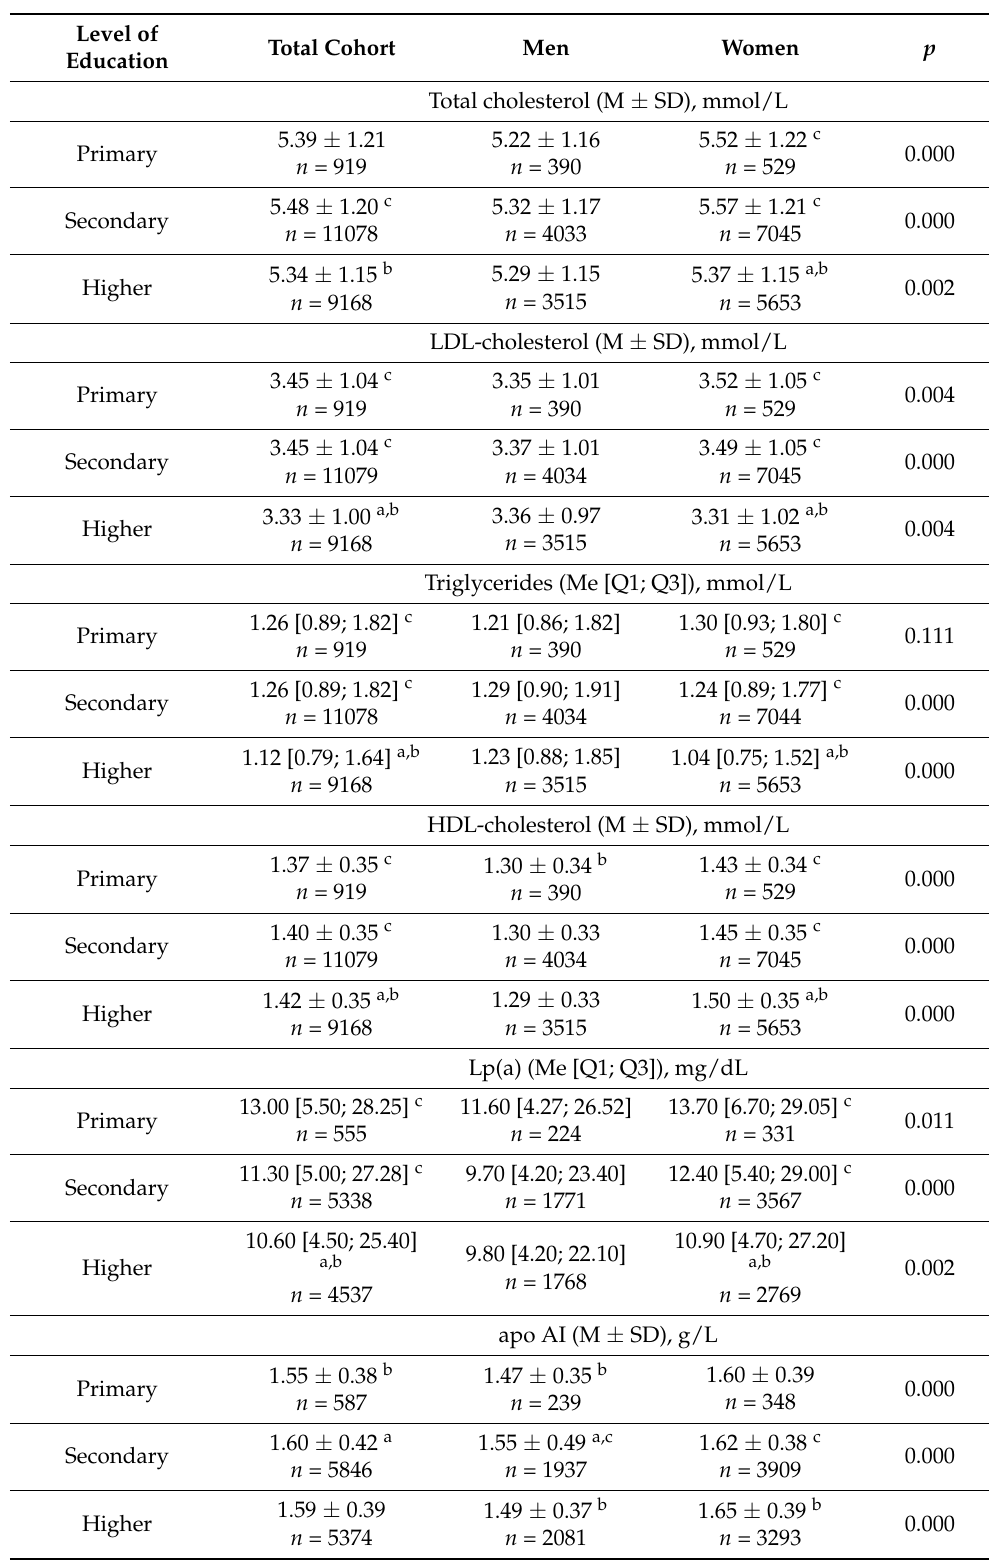
Table 1. Lipoprotein profile parameters in men and women differing in education level among populations from regions of the Russian Federation: ESSE-RF